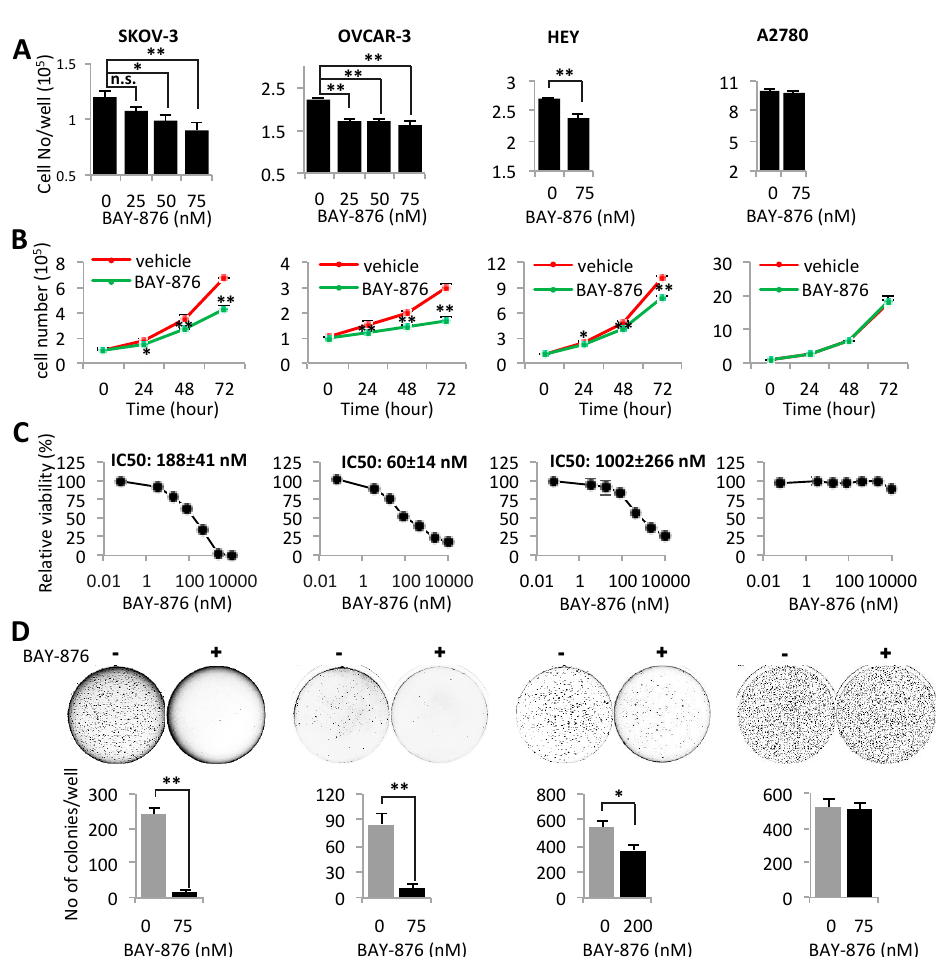
Figure 4. GLUT1 activity is crucial for cell growth. SKOV-3, OVCAR-3, HEY, and A2780 were cultured in 12-well plates with or without BAY-876 at indicated concentrations. The effects of BAY-876 on cell proliferation were analyzed by determination of cell numbers after 24 h ( A ) and 72-h growth curves ( B ). In ( C ), ovarian cancer cell lines were treated with indicated concentrations of BAY-876 for 72 h before the MTT assay to determine the cytotoxic effect of the compound. IC 50 in each cell line was calculated using SigmaPlot 13.0 (Systat Software, San Jose, CA, USA). The effects of BAY-876 (75 nM for SKOV-3 and OVCAR-3, and 200 nM for the less sensitive HEY) on anchorage-independent growth were determined by soft agar assay ( D ). The data was presented as number of colonies per well. * p < 0.05; ** p < 0.01.